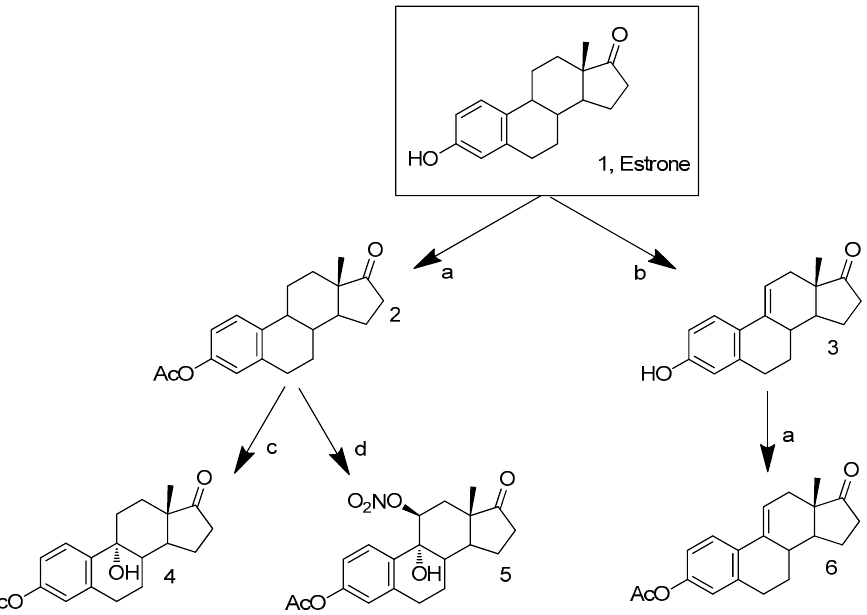
Scheme 1. Synthetic route to prepare the C-ring oxidized estrone acetate derivatives 4 , 5 and 6 . Reagents and conditions: (a) acetic anhydride, DMAP, THF, rt; (b) DDQ, MeOH, reflux; (c) Oxone TM , acetone, CH 2 Cl 2 , H 2 O, NaHCO 3 , TBAHS, 15 °C; (d) CAN, H 2 O, acetic acid, rt. Table 1. IC 50 ( µ M) of compounds 2 , 4 – 6 and 5-fluorouracil (5-FU) against MCF-7, T47-D, LNCaP, HepaRG, and Caco-2 cancer cells and normal fibroblasts (NHDF) a . Compounds MCF-7